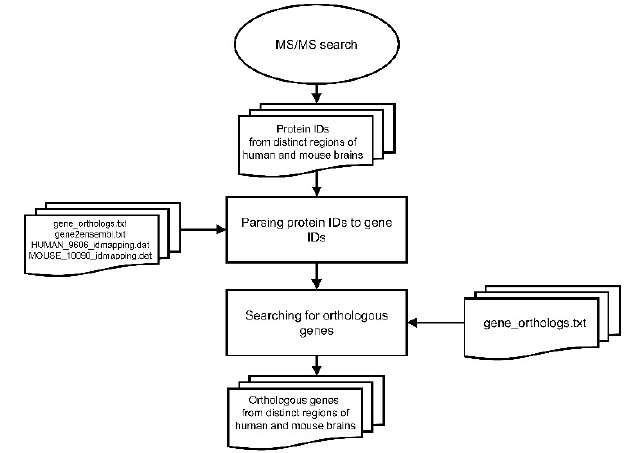
Figure 1. Flowchart for ortholog assessment.